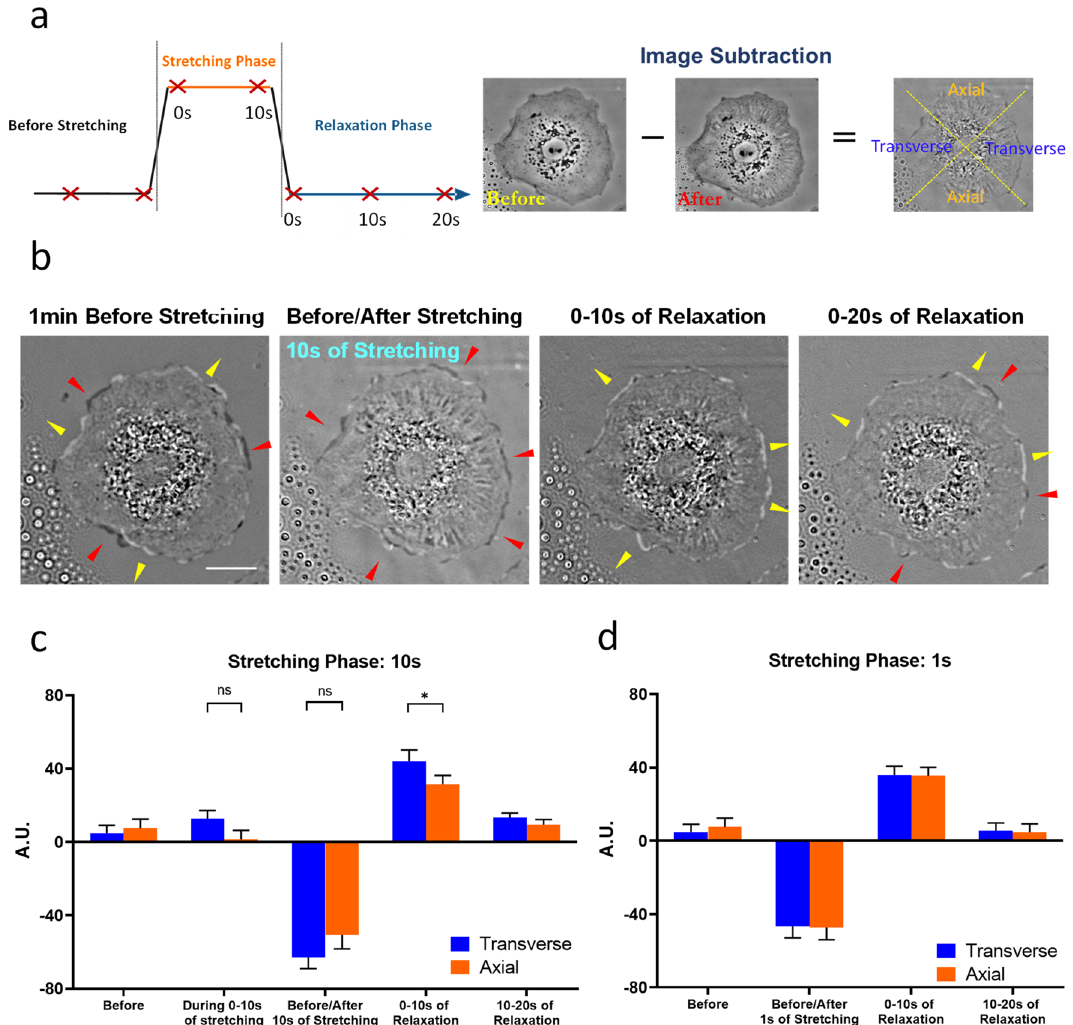
Figure 3. Distinct protrusive and retractive responses to a single pulse of stretching. ( a ) Images are collected before, during, and after stretching, as indicated by red crosses (left diagram). Shape changes are detected by difference imaging between consecutive images. Each cell is divided into two axial and two transverse quadrants, by drawing two diagonal lines at the centroid (right diagram). ( b ) Dark (red arrows) and bright (yellow arrows) regions in the difference image indicate retraction and protrusion, respectively. ( c ) Before and during 10 s of stretching, cells show only randomly distributed retractions and protrusions, resulting in little net change in peripheral area for transverse or axial quadrants. ( b , c ) Strong retractions occur immediately upon relaxation, while protrusions dominate during the following 10 s of relaxation. ( d ) Reducing the duration of stretching to 1 s has no significant effect on the extent of retraction but reduces the subsequent transverse extension (scale bar, 20 μm; n.s. p > 0.05, * p < 0.05; n = 20, mean ±